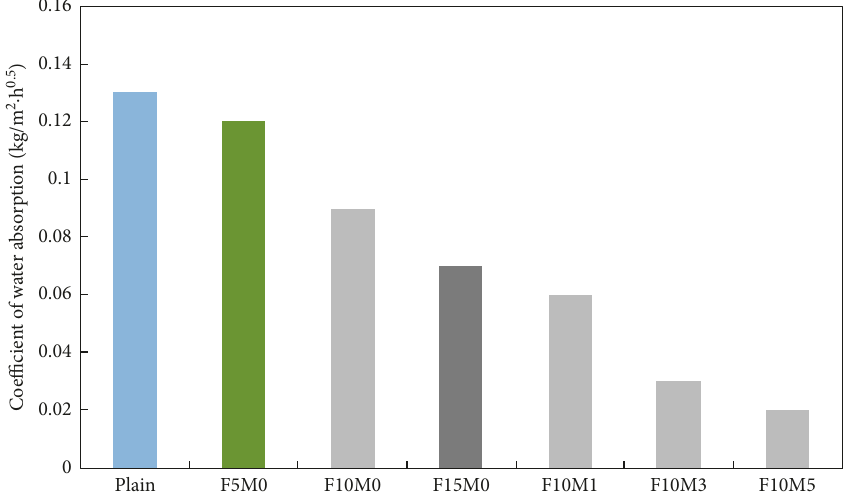
Figure 11: Coefficient of water absorption of the cement mortar with